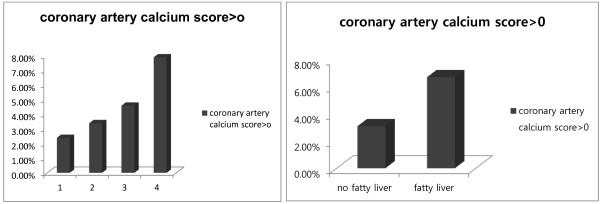
The prevalence of CAC score > 0 2.4% in baPWV Quartile 1 (Q1), 3.4% in 2 (Q2), 4.6% in 3 (Q3), 7.9% in 4 (Q4) (p < 0.001) and 3.1% in no fatty liver group, 6.7% in fatty liver group. (p < 0.001).